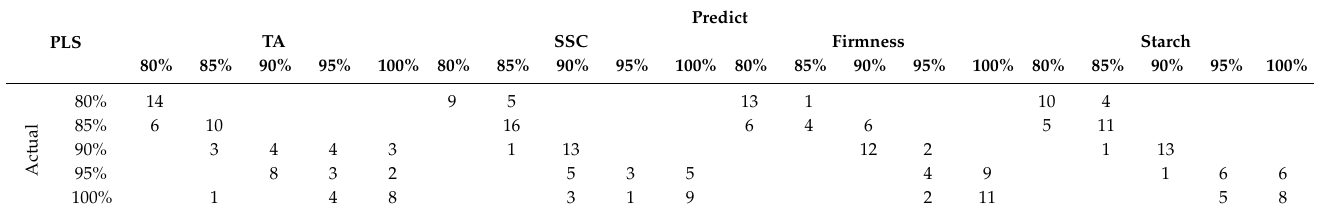
Table 7. The results of the confusion matrix using PLS based on the